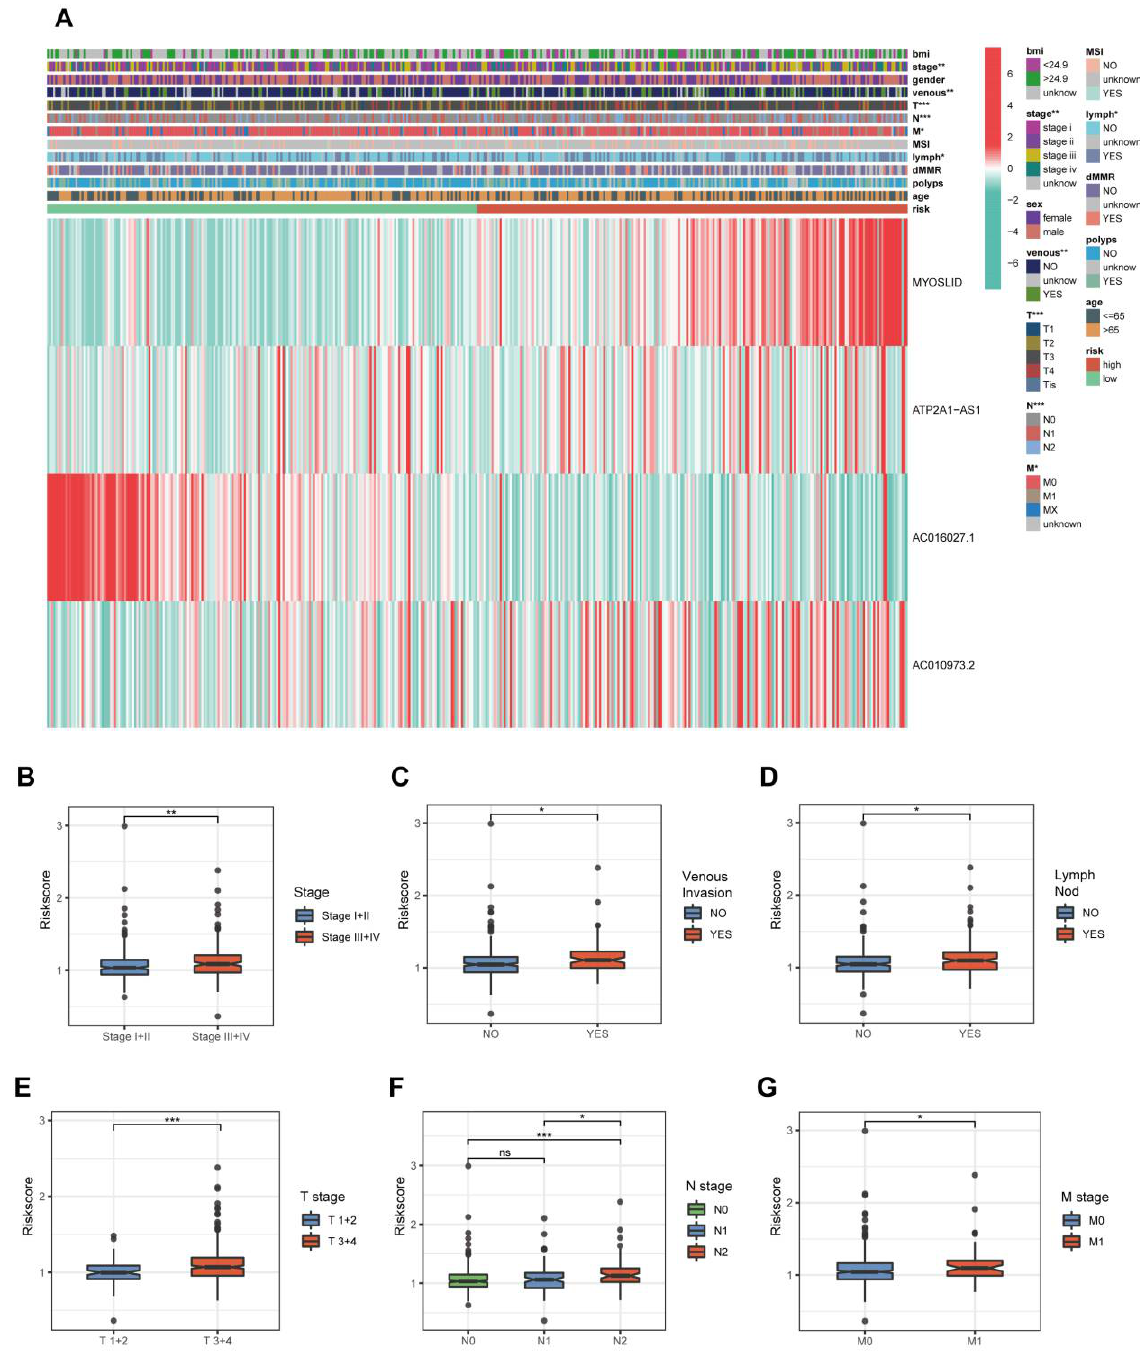
Figure 5. Relationship between the 4-NRL model and some representative clinicopathological features in CRC patients. ( A ) Heatmap showing the distribution of 12 representative clinicopathological features and the expression levels of 4 NRLs in CRC patients. ( B – G ) Histograms show the differences in the risk scores of CRC patients stratified by stage, T stage, N stage, M stage, lymph invasion and venous invasion. *: p < 0.05, **: p < 0.01, and ***: p < 0.001. ns: No significance.